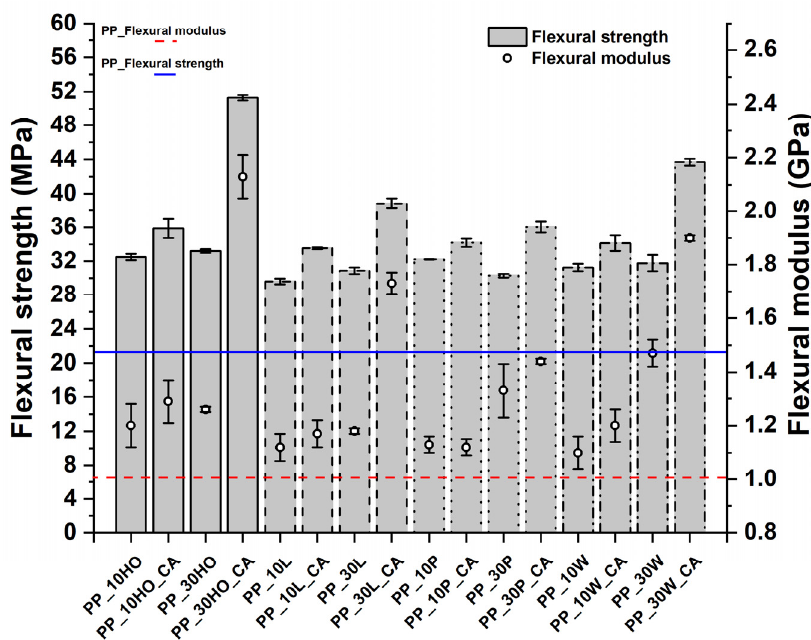
Figure 17. Flexural strength and modulus values of PP-based composites.